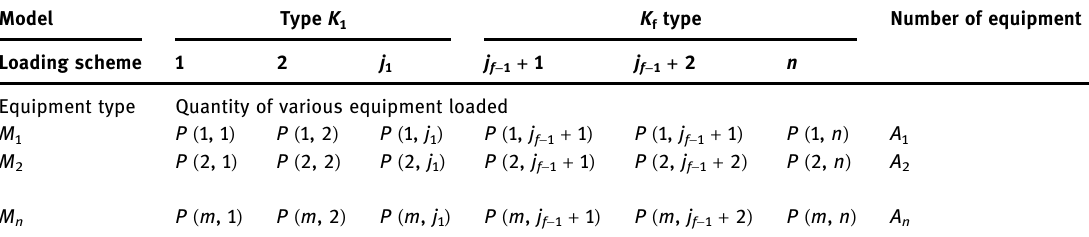
Table 1: Schematic diagram of all possible loading methods